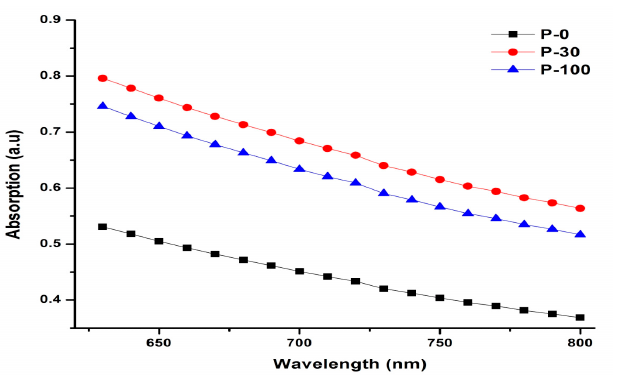
Figure 3. Experimentally measured values of absorption from UHMWPE sample over the spectral range of interest, i.e., 600 nm to 800 nm.